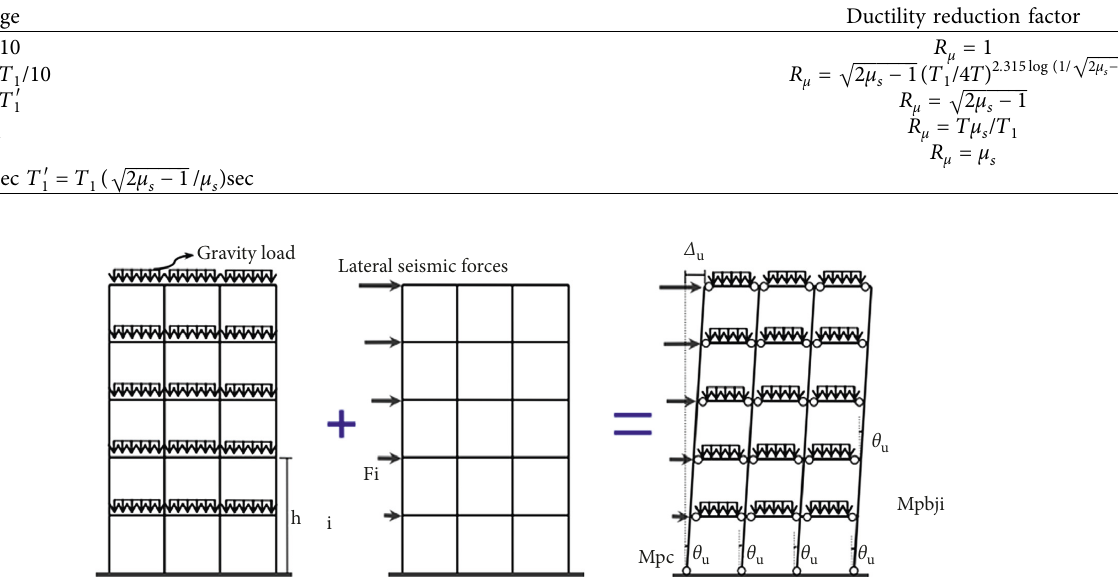
Figure 2: A frame’s yield mechanism [24].